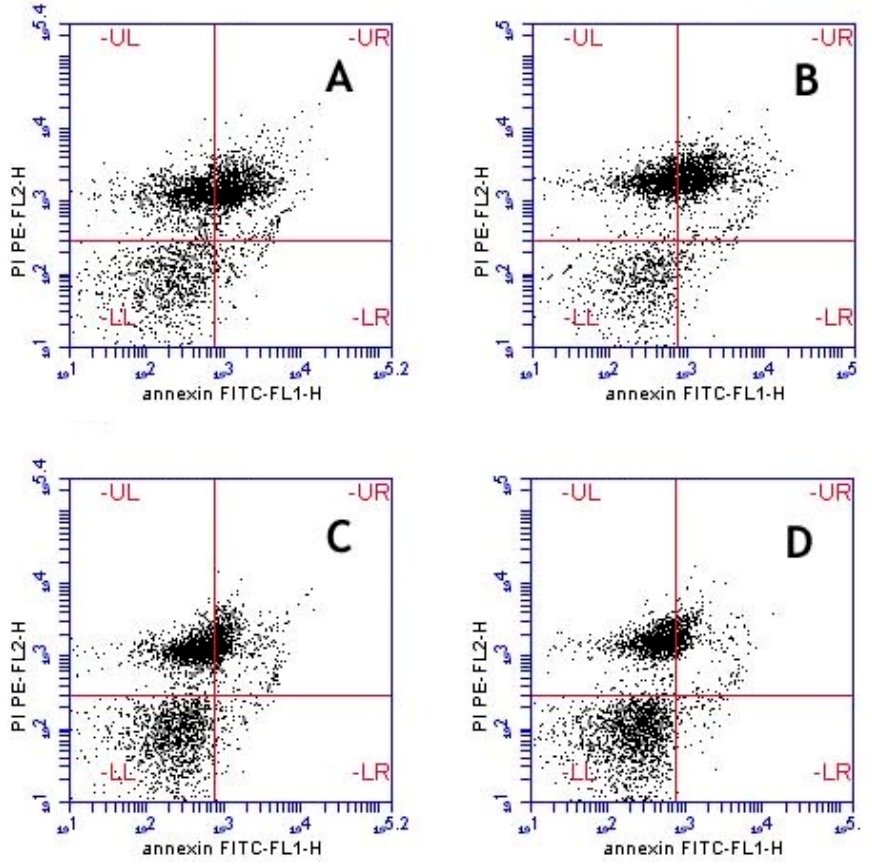
Figure 2. Flow cytometry contour plots of frozen/thawed spermatozoa labelled with annexin V-fluorescein isothiocyanate (FITC) fluorescence and propidium iodide (PI) fluorescence. ( A ) Control; ( B ) A. harveyi leaf extract 0.5 µ g/mL; ( C ) A. harveyi leaf extract 1 µ g/mL; ( D ) Leaf extract 1.5 µ g/mL. In each graph, the upper right quadrant (UR) represents apoptotic spermatozoa binding annexin-V and PI (A+/PI+). The upper left quadrant (UL) represents necrotic cells excluding annexin-V and binding PI (A − /PI+). The lower left quadrant (LL) contains viable spermatozoa, which are negative for annexin-V and exclude PI staining (A − /PI − ). The lower right quadrant (LR) shows early apoptotic spermatozoa, which bind annexin-V but exclude PI (A+/PI −